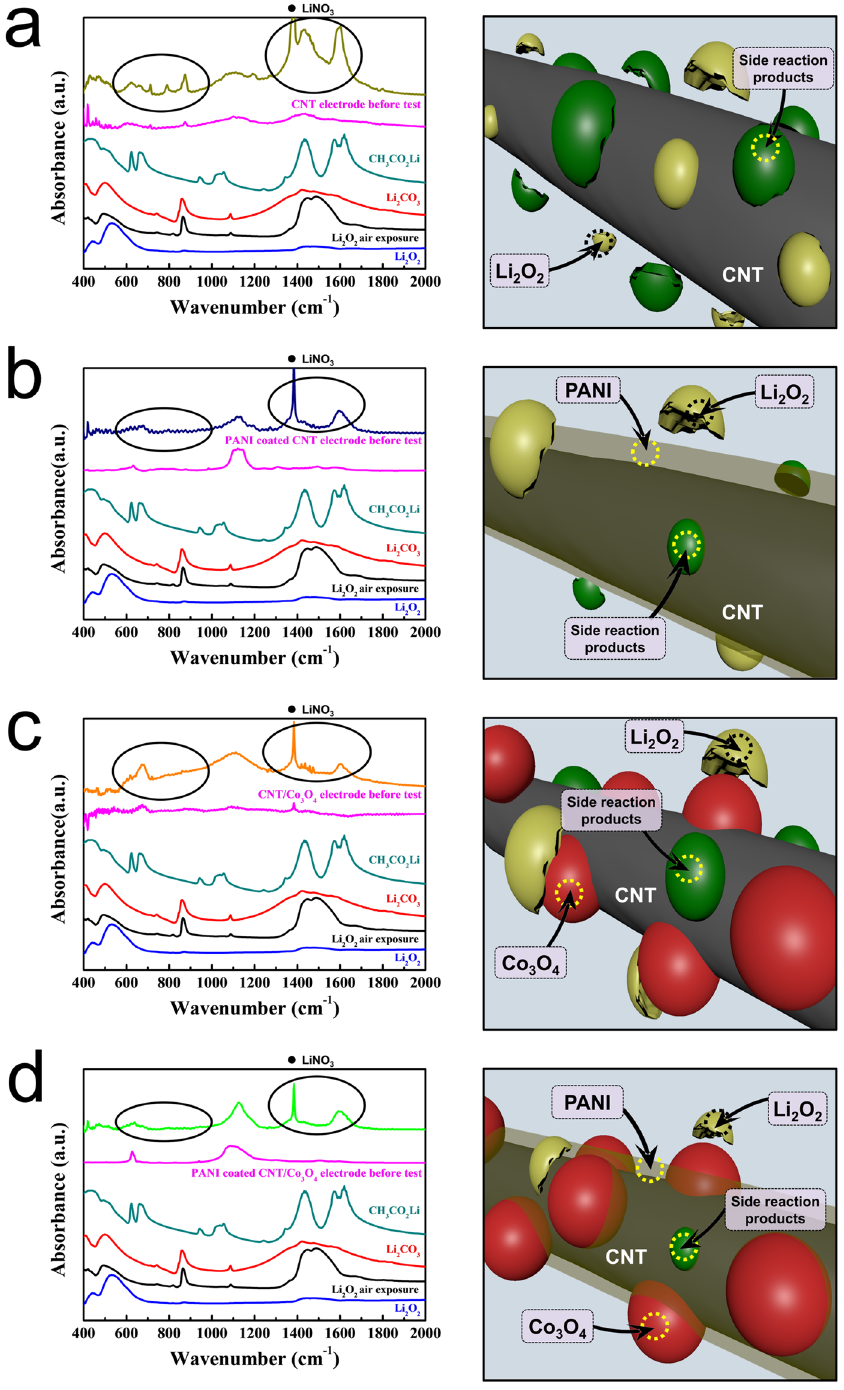
Figure 6. FTIR spectra of the electrodes (left column) after 50 cycles (charged state) and illustrations (right column) of the reactions taking place on the electrode surfaces. ( a ) The pristine electrode, ( b ) the PANI electrode, ( c ) the comp electrode, and ( d ) the PANI-comp